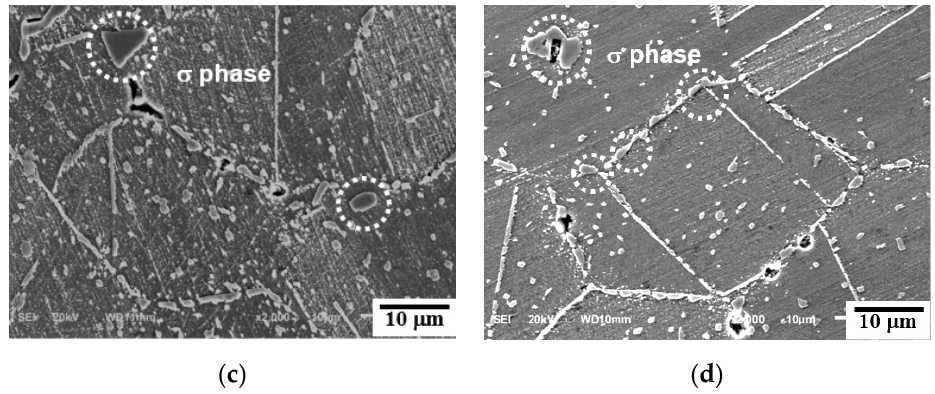
Figure 7. SEM micrographs from cross-sectional fractures of creep specimens: ( a ) 750 °C/150 MPa/222 h, ( b ) 750 °C/110 MPa/925 h, ( c ) 750 °C/90 MPa/2310 h, and ( d ) 750 °C/70 MPa/4680 h.